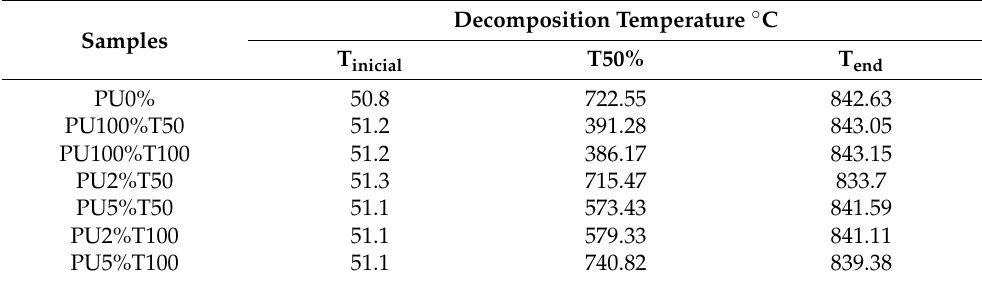
Table 5. Decomposition temperatures of